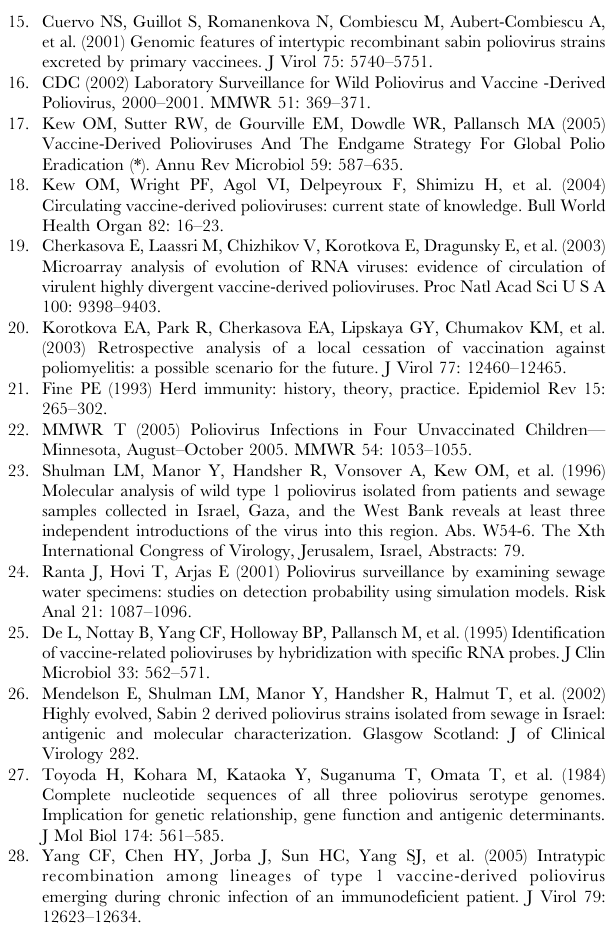
Table S2 Pair-wise nucleotide homology among aVDPVs and Sabin